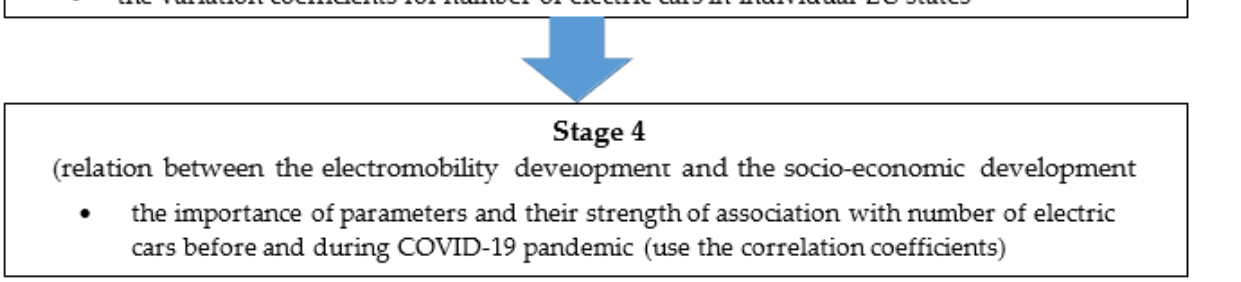
Figure 1. Scheme of the conducted research.